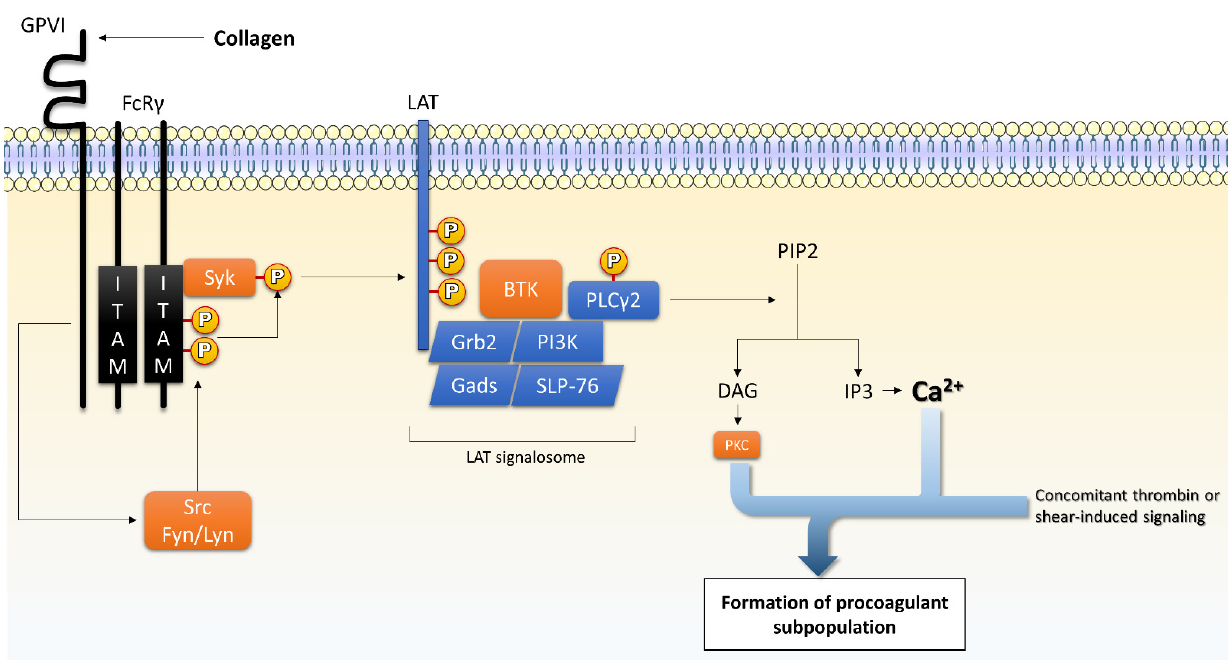
Figure 3. Collagen-mediated signaling via glycoprotein (GP) VI. In addition to adhesion mediated by GPIa-IIa (integrin α 2 β 1), collagen induces platelet activation via GPVI. It triggers the formation of IP3 releasing Ca 2+ from internal stores. PKC isoforms also participate in further platelet activation. This figure is inspired from [138–140]. Legend: BTK: Bruton’s kinases; Ca 2+ : calcium; DAG: diacyl- glycerol; FcR γ : Fc receptor γ -chain; IP3: inositol trisphosphate; ITAM: immunoreceptor tyrosine activation motif; LAT: linker for activation of T cells; MAPK: mitogen-activated protein kinases; PI3K: phosphatidylinositide-3-kinase; PIP2: phosphatidylinositol-4,5-bisphosphate; PLC γ 2: phospholipase C γ 2; Rap1: Ras-related protein 1; Syk: spleen tyrosine kinase; TXA2: thromboxane A2.